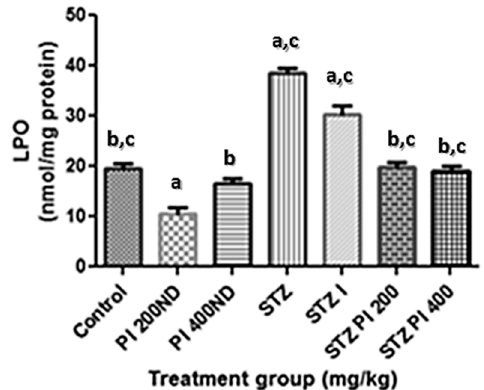
Figure 2. Effects of protein isolate from Parkia biglobosa on lipid peroxidation level in experimental animals. Data in the figure above represents mean ± standard deviation, n = 10. a —compared with control, b —compared with STZ only, c —compared with treated non-diabetic groups. Values are statistically significant at p < 0.05.